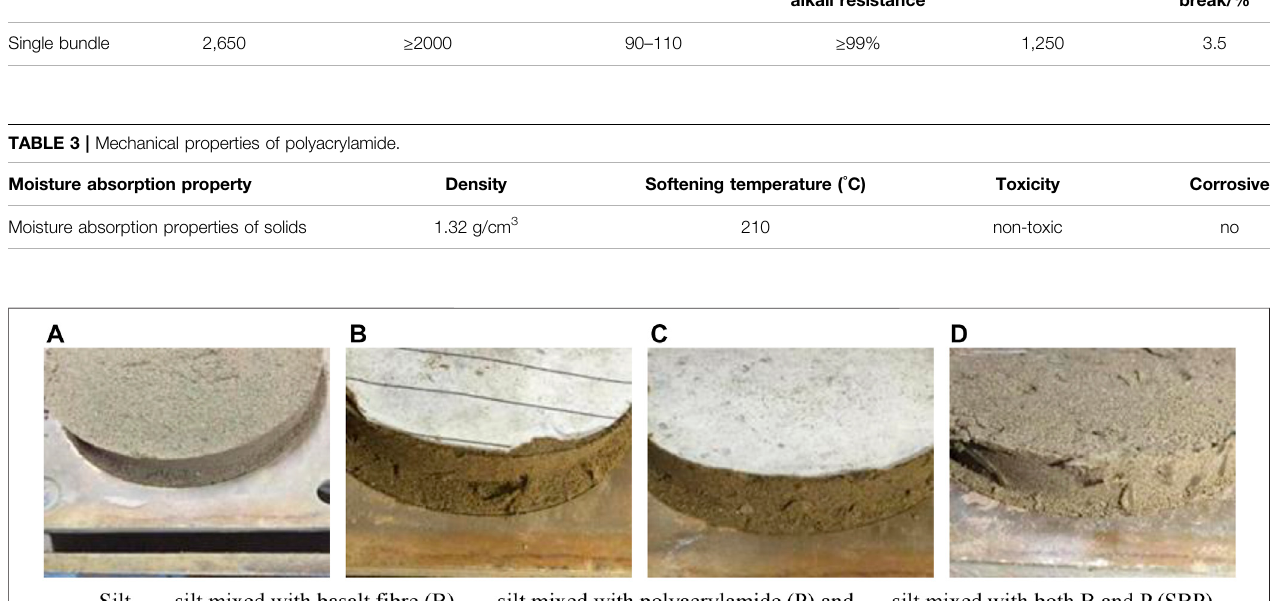
Frontiers in Earth Science |